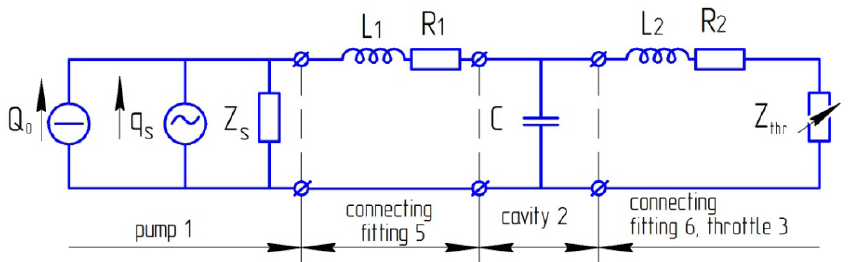
Figure 18. Calculated hydrodynamic model of a bench system implementing the capacitive load. R 1 , L 1 —active resistance and “inertia” of connection fittings and internal channel in the pump and cavity, respectively; C—capacitance; R 2 , L 2 —active resistance and “inertia” of connecting nipples and internal channel in the cavity and throttle, respectively; Z thr —throttle impedance.